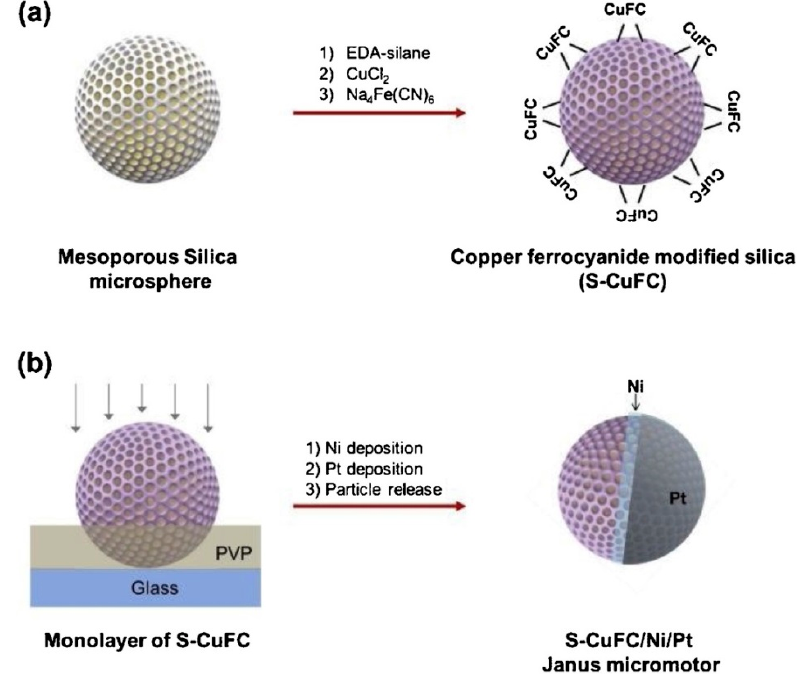
Figure 6. Scheme of the S-CuFC microspheres synthesis ( a ), and the sequential deposition of ferromagnetic Ni and catalytic Pt on half of the S-CuFC surface ( b ) for the fabrication of S-CuFC/Ni/Pt Janus micromotors. Reproduced from Reference [33] with permission.